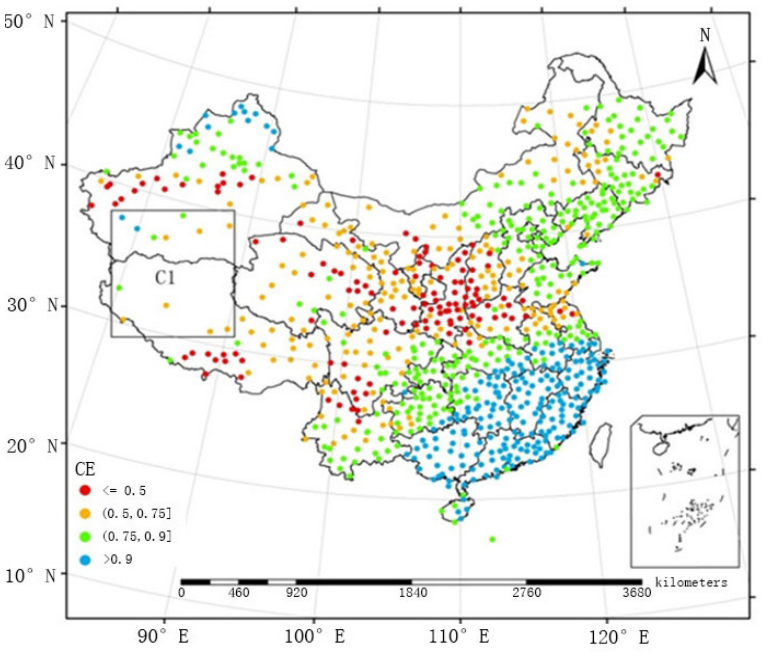
Figure 6. Spatial distribution map of the CE obtained by FMP between May and September from 2005 to 2010.